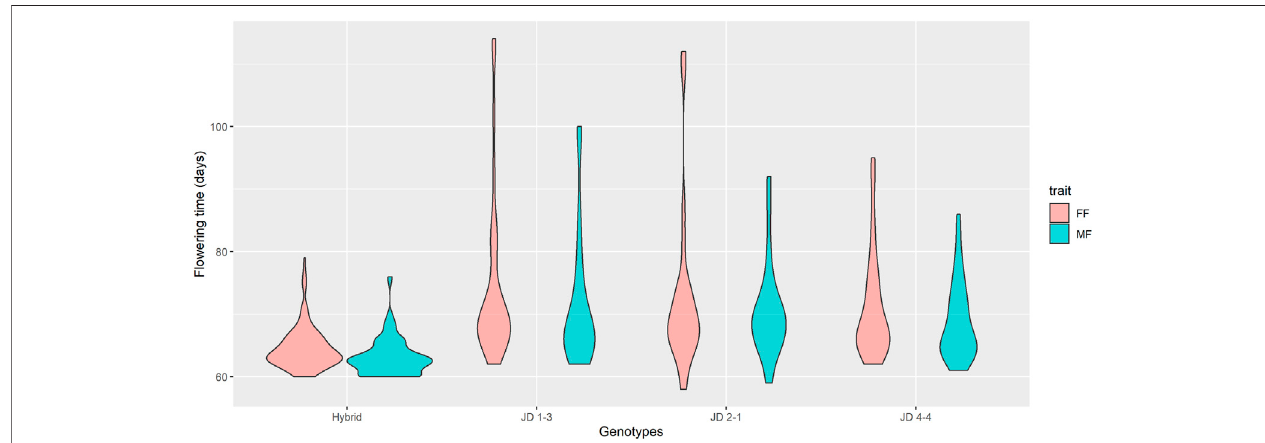
FIGURE 4 | Flowering time among inbred line families and hybrids. The violin plot shows the FT distribution in days for all analyzed materials. The violin shape represents the estimated value of the density of the trait within each group. Hybrid, n (cid:1) 175; JD 1-3, n (cid:1) 36; JD 2-1, n (cid:1) 25; JD 4-4, n (cid:1) 63.